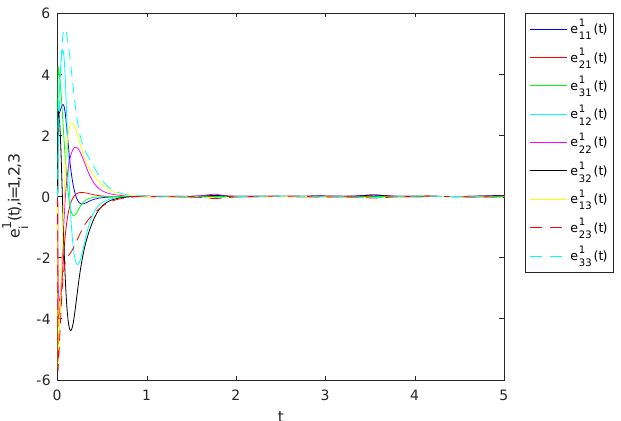
Figure 5. Synchronization error in the first layer under Controller (4).